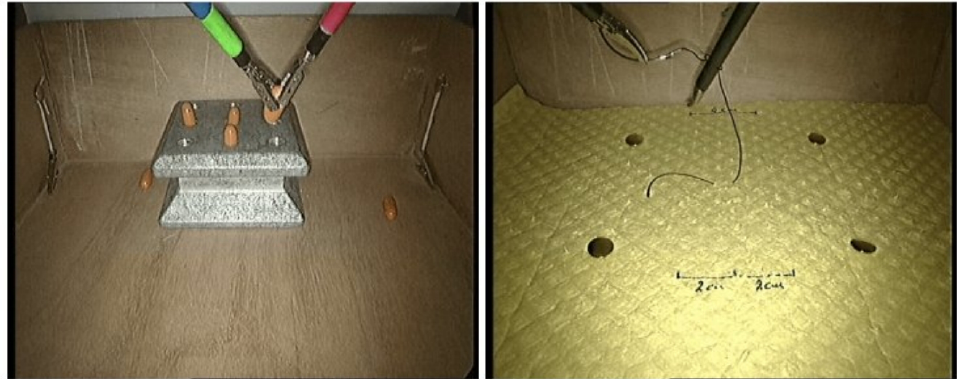
Figure 1. Sample frames extracted from the videos of the surgical tasks (left: PT, right: